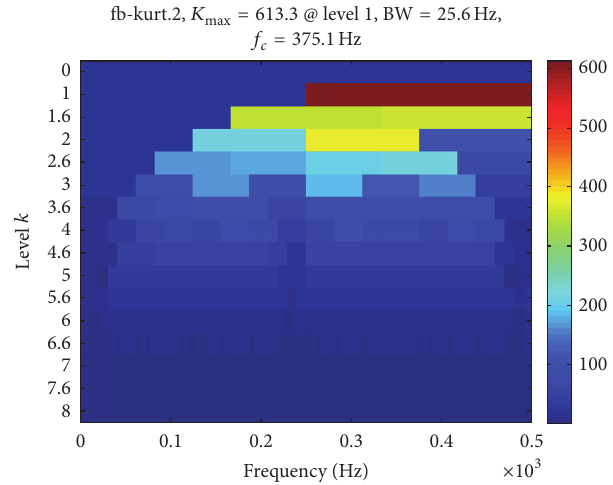
Figure 5: The calculation of the kurtosis.